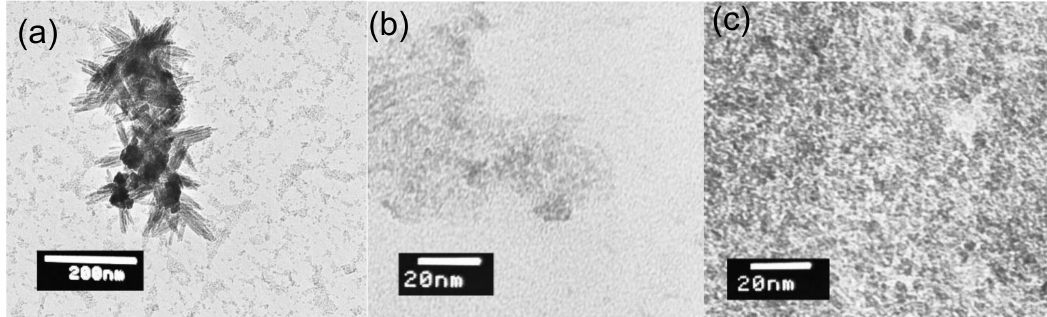
Figure 4. TEM images of the primary particles and their aggregates obtained at precursor concentration of 1.37 M TiCl 4 and oily phase containing Span 80 of concentration ( a ) 0.1 wt %, ( b ) 1 wt %, or ( c ) 3 wt % in